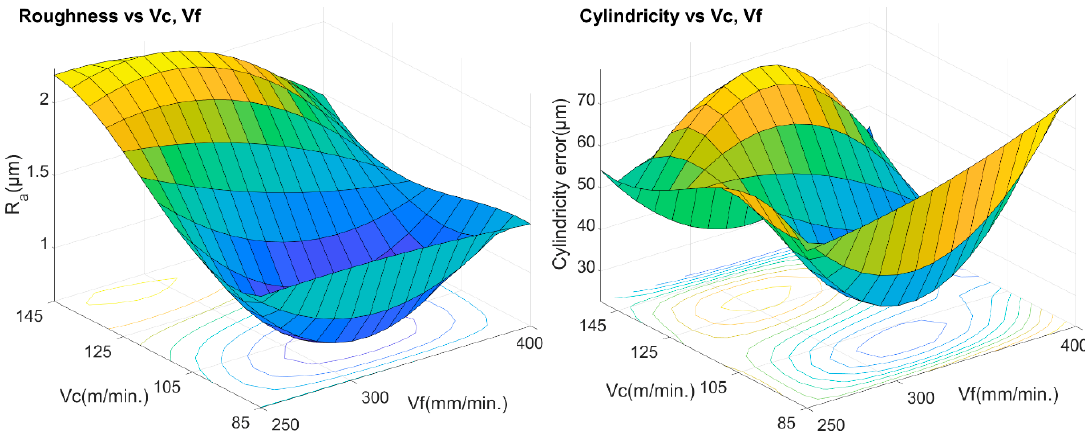
Figure 8. Effects of cutting speed and feed rate on the average roughness (left) and cylindricity (right).